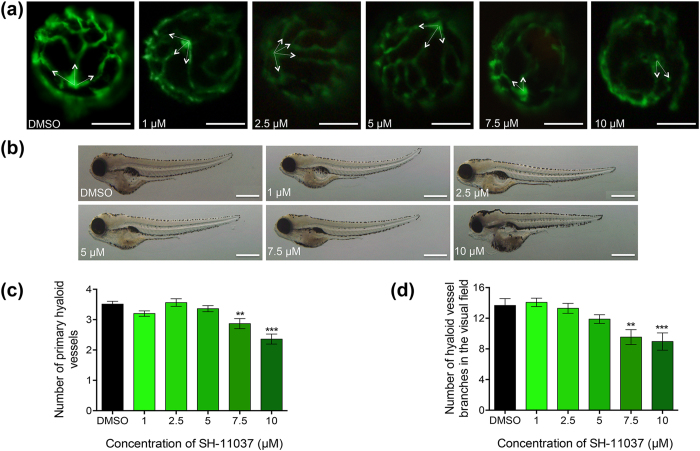
SH-11037 significantly inhibits ocular developmental angiogenesis in zebrafish larvae.(a) Representative epi-fluorescence images of hyaloid vessel (HV) morphology on lenses dissected from drug-treated 5 days post fertilisation (dpf) Tg(fli1:EGFP) larvae. A significant reduction in primary HV branch number is observed at 10 μM SH-11037 (white arrows), scale bars = 50 μm. (b) Representative bright-field images of 5 dpf larval morphology following SH-11037 treatment. Some larvae treated with 10 μM SH-11037 demonstrated pericardial and yolk sac oedema. Scale bars = 500 μm. (c) Quantification of the dose-dependent inhibition of primary HV development in 5 dpf Tg(fli1:EGFP) larvae treated from 2 dpf with 1–10 μM SH-11037. (d) Quantification of the dose-dependent inhibition of SH-11037 on number of hyaloid vessel branches in treated larvae compared to DMSO control. Up to a 40% reduction in primary HV and vessel branches is observed in response to 10 μM SH-11037. ***P <0.01, ***P < 0.001, one-way ANOVA with Dunnett’s post hoc tests. Mean ± s.e.m., n ≥ 3.